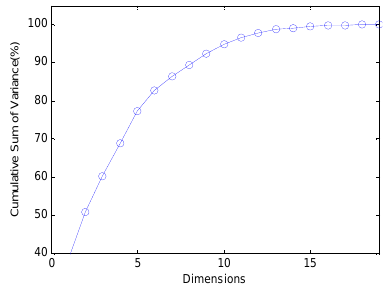
Figure 10. The curve of cumulative sum of variance with dimensions.